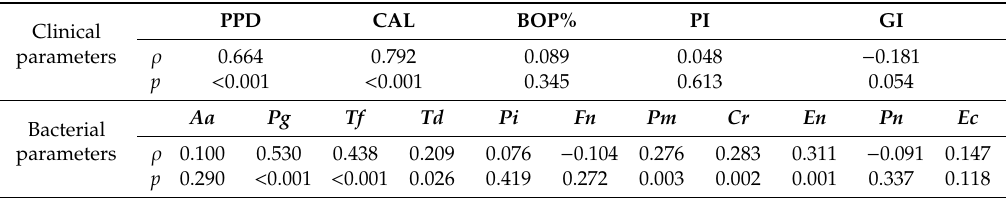
Table 6. Correlations between the severity of periodontal disease and clinical parameters and bacterial parameters. All bacterial parameters indicate the DNA counts of each bacterial species in the mouthwash